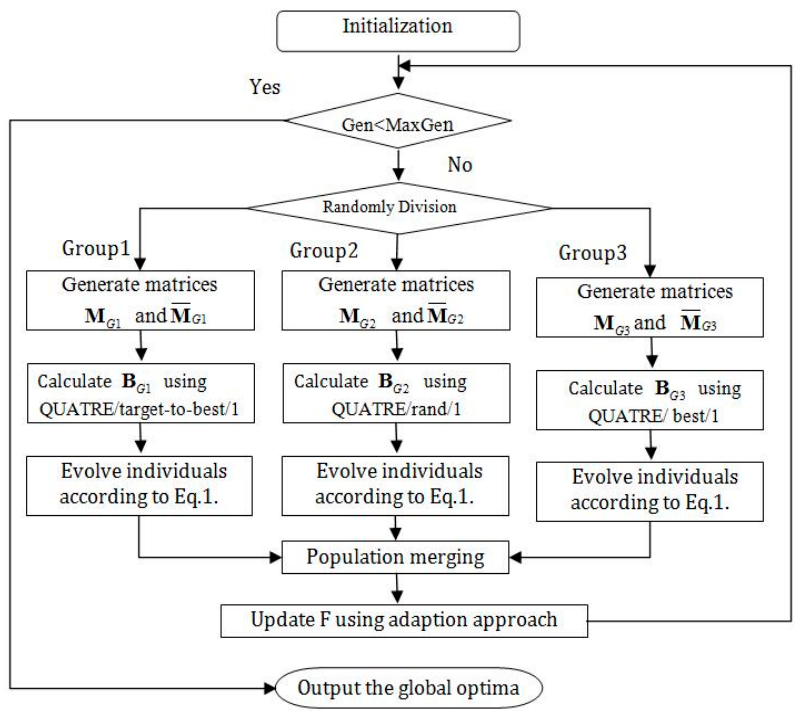
Figure 1. The main framework of adaptation multi-group quasi-affine transformation evolutionary algorithm (AMG-QUATRE).